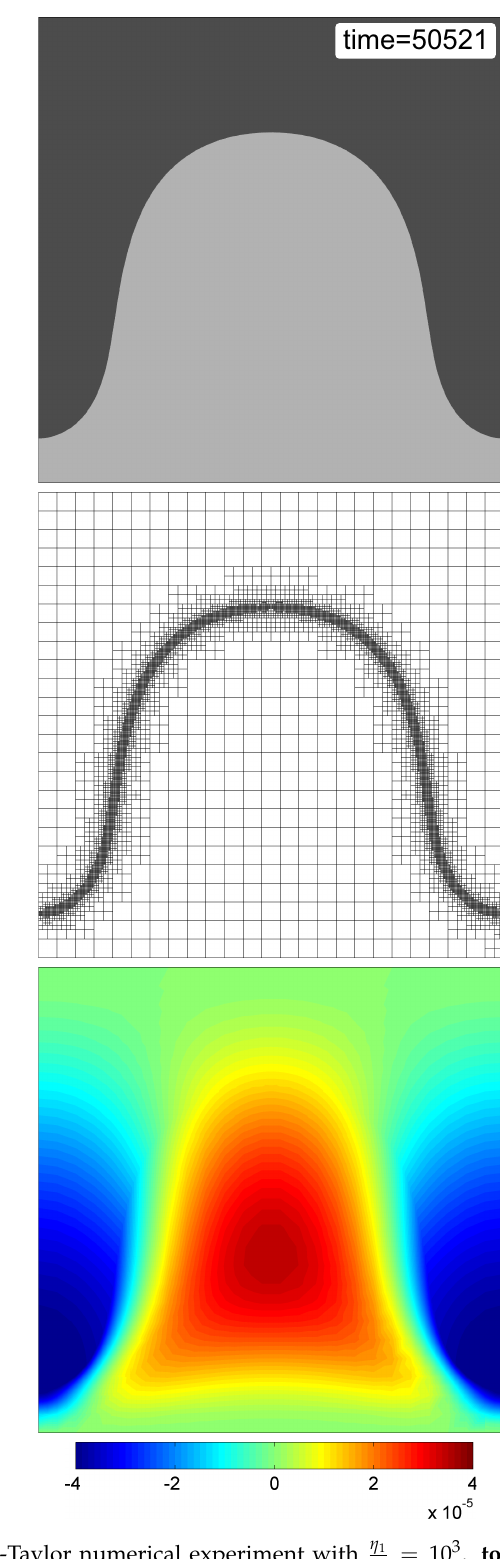
Figure 30. Results of Rayleigh-Taylor numerical experiment with η 1 middle : numerical grid; bottom : v y -velocity